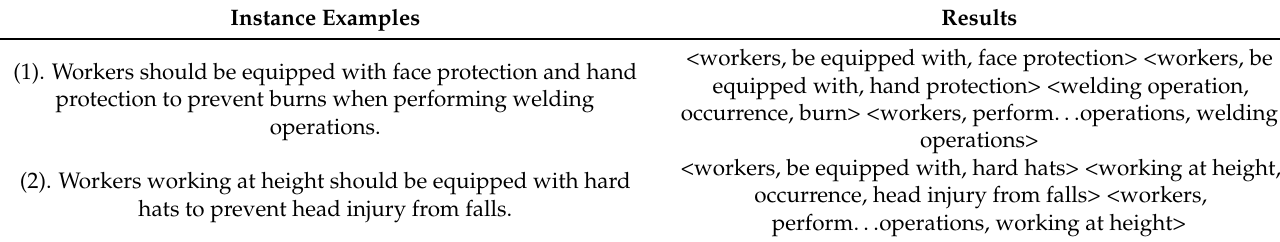
Table 3. Case study of regulations information